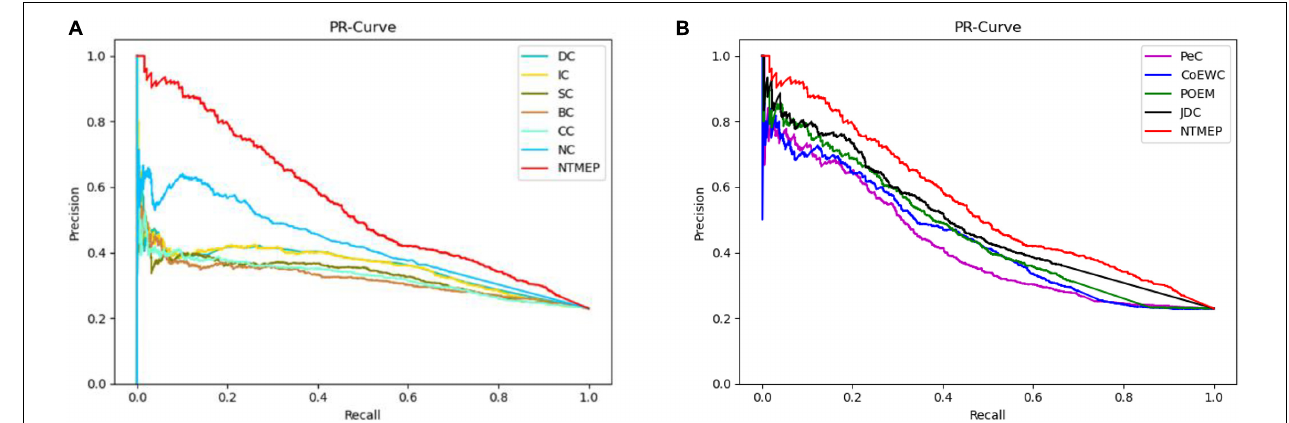
FIGURE 2 | Performance comparison between NTMEP and other ten methods in terms of PR curves. (A) PR curves of DC, IC, SC, BC, CC, NC, and NTMEP; (B) PR curves of PeC, CoEWC, POEM, JDC, and NTMEP.